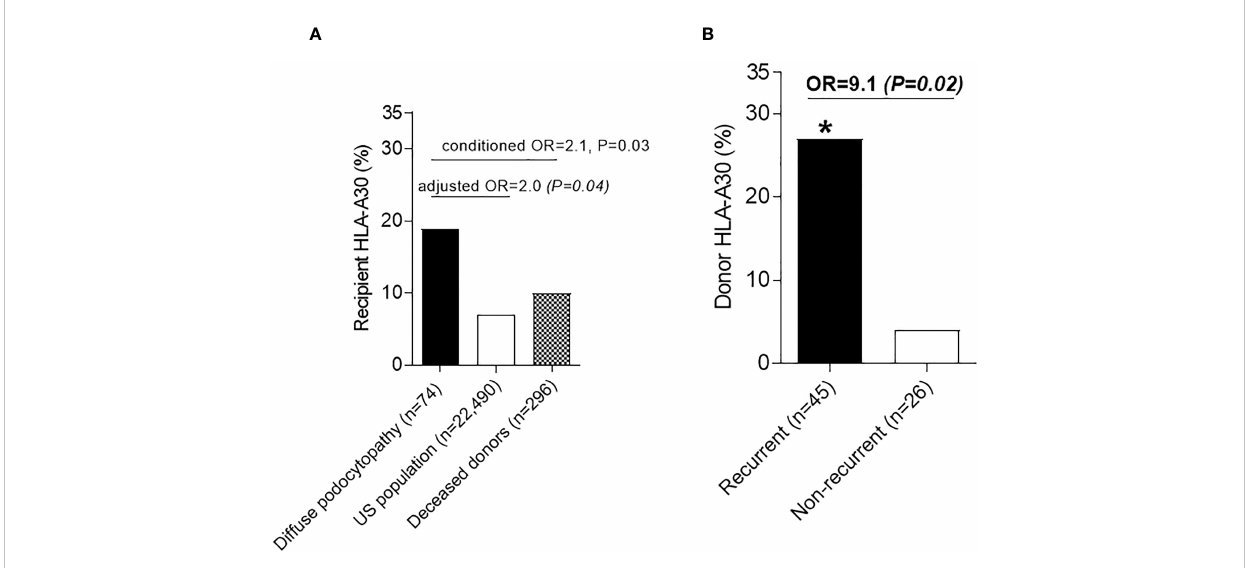
FIGURE 1 Human Leukocyte antigens in diffuse podocytopathy (A) Prevalence of HLA-A30 antigen in cases with diffuse podocytopathy (patients with end stage kidney disease due to diffuse podocytopathy, n=74) compared to US population (n=22,490) and deceased kidney donors matched to cases with regard to race/ethnicity (n=296). (B) Prevalence of HLA-A30 in the kidney donors of patients with recurrent (n=42) vs. non-recurrent (n=22) diffuse podocytopathy. Donor typing for class-I was not available for 2 donors with recurrent diseases and 1 without recurrent disease. * (signi fi cant P